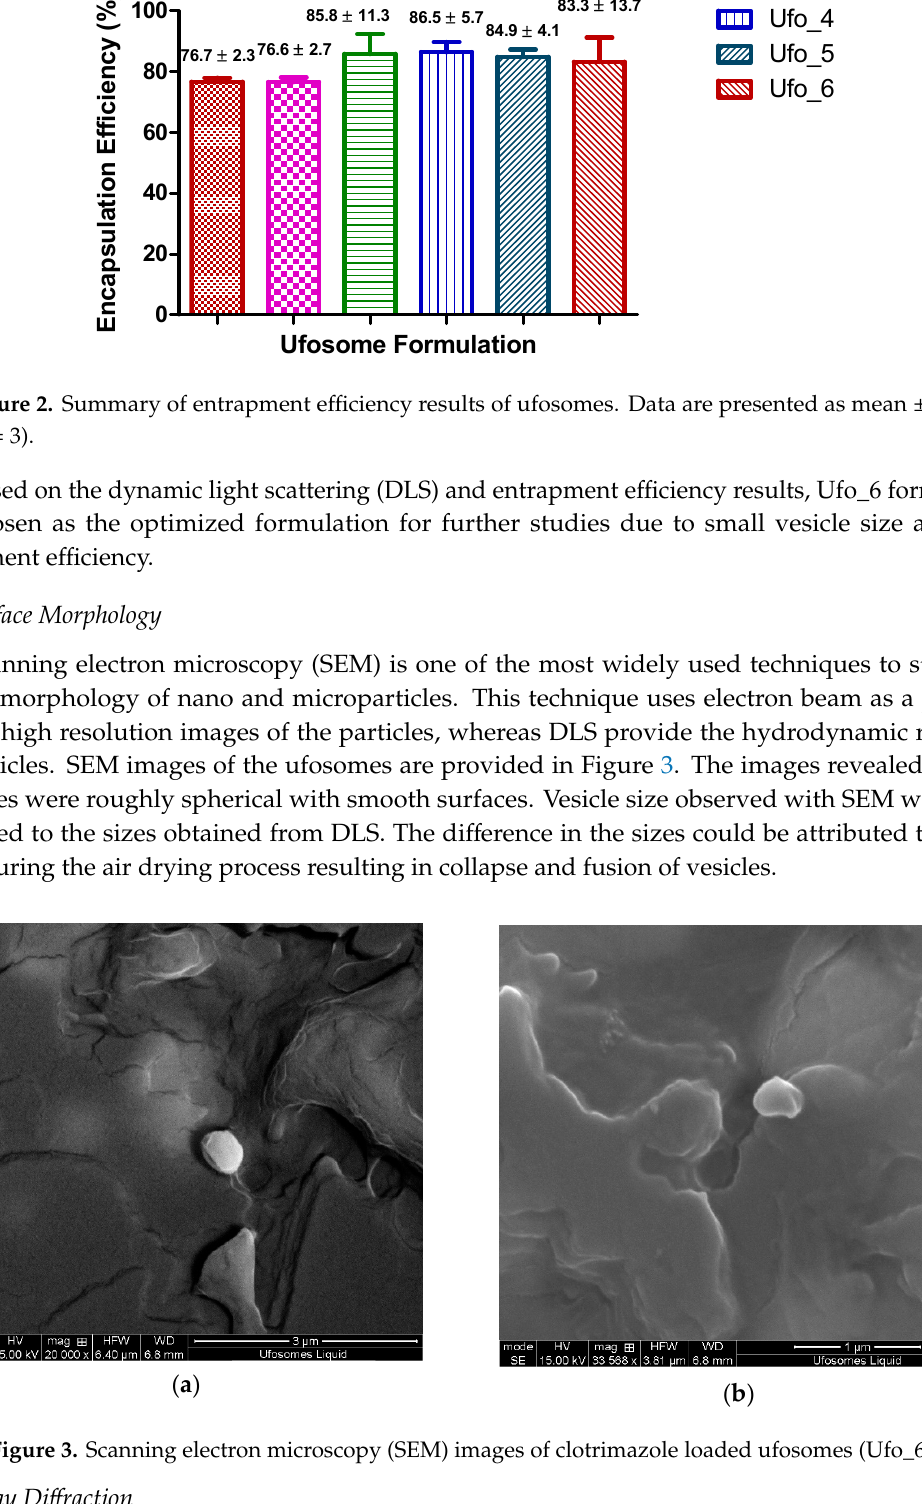
Figure 3. Scanning electron microscopy (SEM) images of clotrimazole loaded ufosomes (Ufo_6).